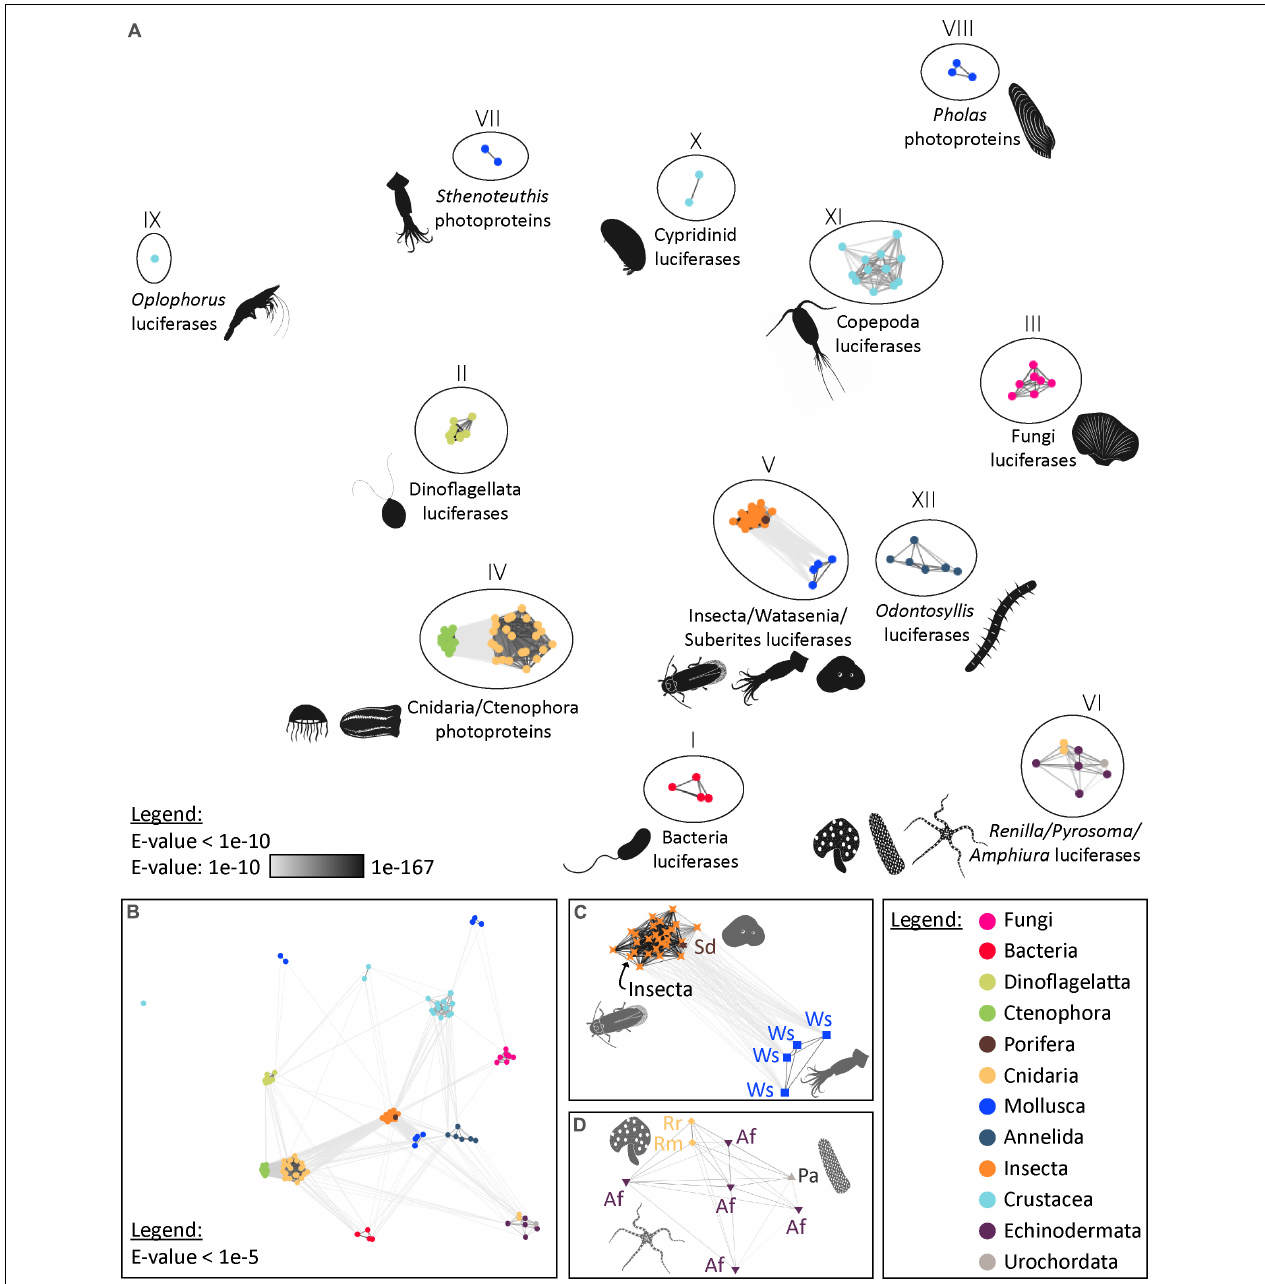
FIGURE 2 | Visualisation of the similarity of known bioluminescent proteins. (A) Sequence-similarity-based clustering approach based on BLASTp e-values (CLANS software) using known luciferases and photoproteins (E-value threshold of 1e − 10 ). (B) Same analysis with an E-value threshold of 1e − 5 . (C) Focus on the Insecta-type luciferase cluster (Group V) that also contains luciferases of Watasenia scintillans and Suberites domuncula (E-value threshold of 1e − 10 ). (D) Focus on the Renilla -type luciferase cluster (Group VI) containing Pyrosoma atlanticum and Amphiura filiformis candidate luciferases (E-value threshold of 1e − 10 ). The names and accession numbers of the sequences are referenced in the Supplementary Table 1